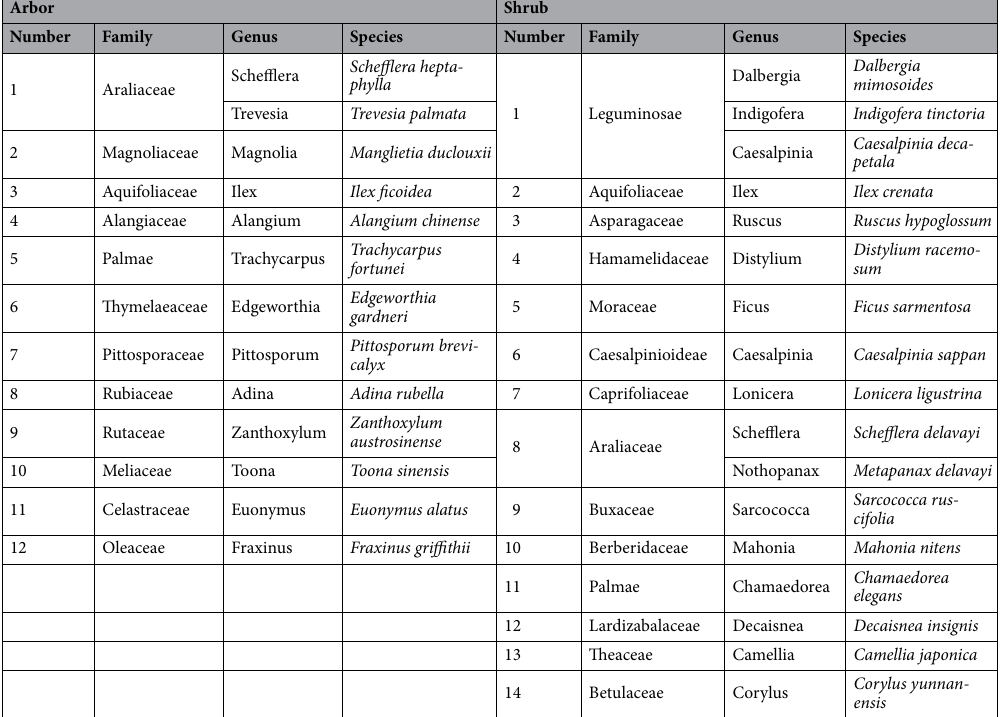
Table 2. Floristic composition of arbor and shrub inside tiankeng.